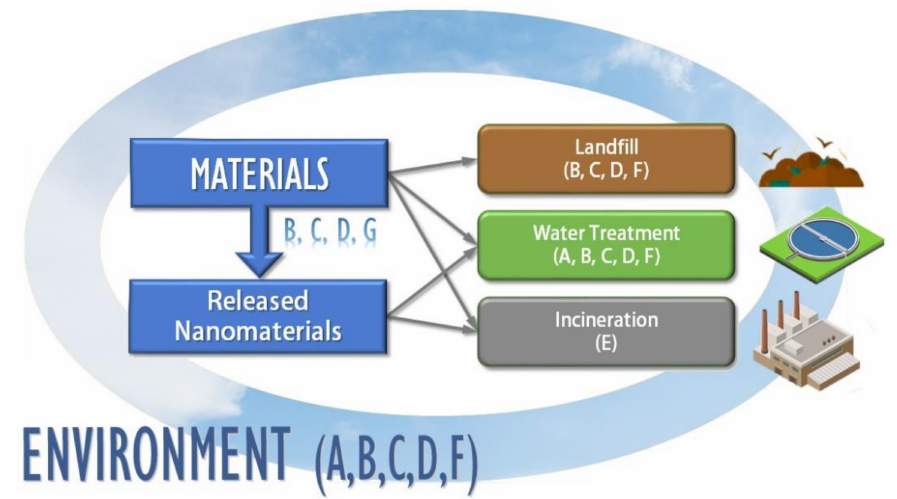
Figure 3. Life-cycle of Ag nanoparticles in socks and their transformations in the different